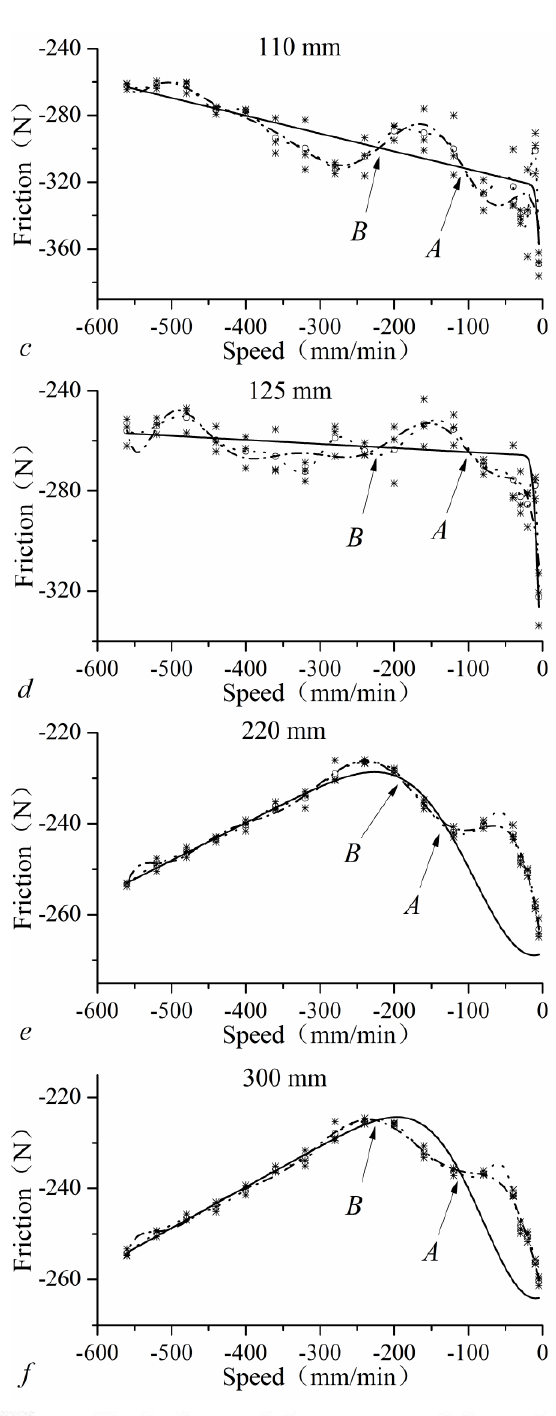
Figure 15. Comparison of the experimental data with three model curves for the backward feed. ( a ) Position of 20mm; (b) Position of 40mm; (c) Position of 110mm; (d) Position of 125mm; (e) Position of ( a ) Position of 20 mm; ( b ) Position of 40 mm; ( c ) Position of 110 mm; ( d ) Position of 125 mm; ( e ) Position 220mm; (f) Position of 300mm. of 220 mm; ( f ) Position of 300